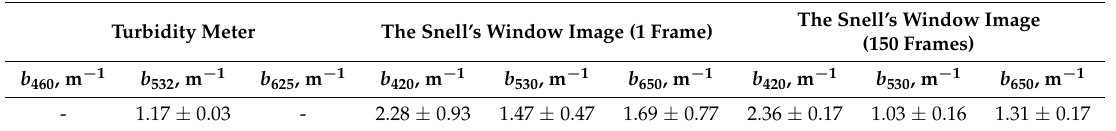
Table 7. The recovery results of the scattering coefficient of the Gorky reservoir from the Snell’s window images in comparison with related data.